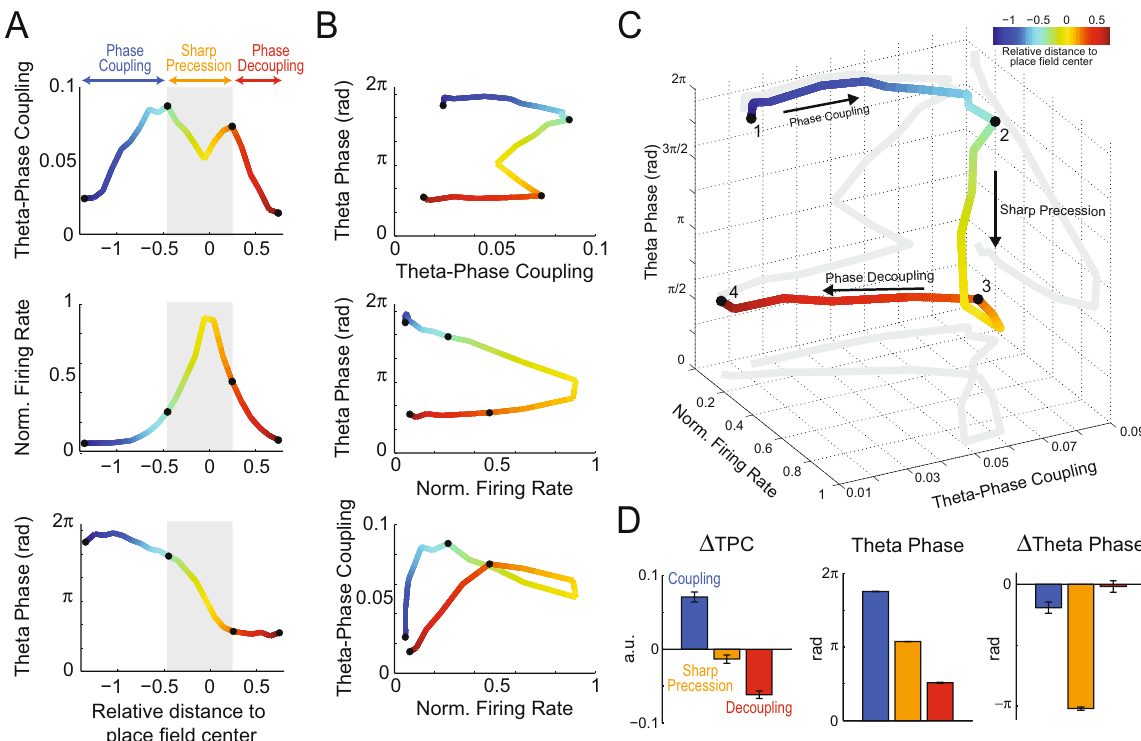
Figure 5. Three-stage model of space coding by place cells. ( A ) Theta-phase coupling strength (top), mean normalized firing rate (middle) and mean theta phase of spiking (bottom) per relative distance. Gray shaded area separates place cell activity along space into three stages, as labeled. ( B ) 2D plots of all pairwise combinations of the independent variables in ( A ). ( C ) 3D plot of theta-phase coupling strength, firing rate and mean spiking theta phase. Gray lines show 2D projections (same curves as in B ). Place cells align to a preferred theta phase before major changes in firing rate and spiking phase (“Phase Coupling”; 1–2). Next, the spiking phase rapidly advances as firing rate peaks (“Sharp Precession”; 2–3). Finally, theta-phase coupling and firing rate return to basal levels while spiking occurs at the same theta phase reached after the precession (“Phase Decoupling”; 3–4). ( D ) Mean change in theta-phase coupling strength (left), mean theta phase of spiking (middle), and mean change in spiking phase (right) during each stage. In ( A – C ), the line color denotes the relative distance to the place field center and black dots mark stage